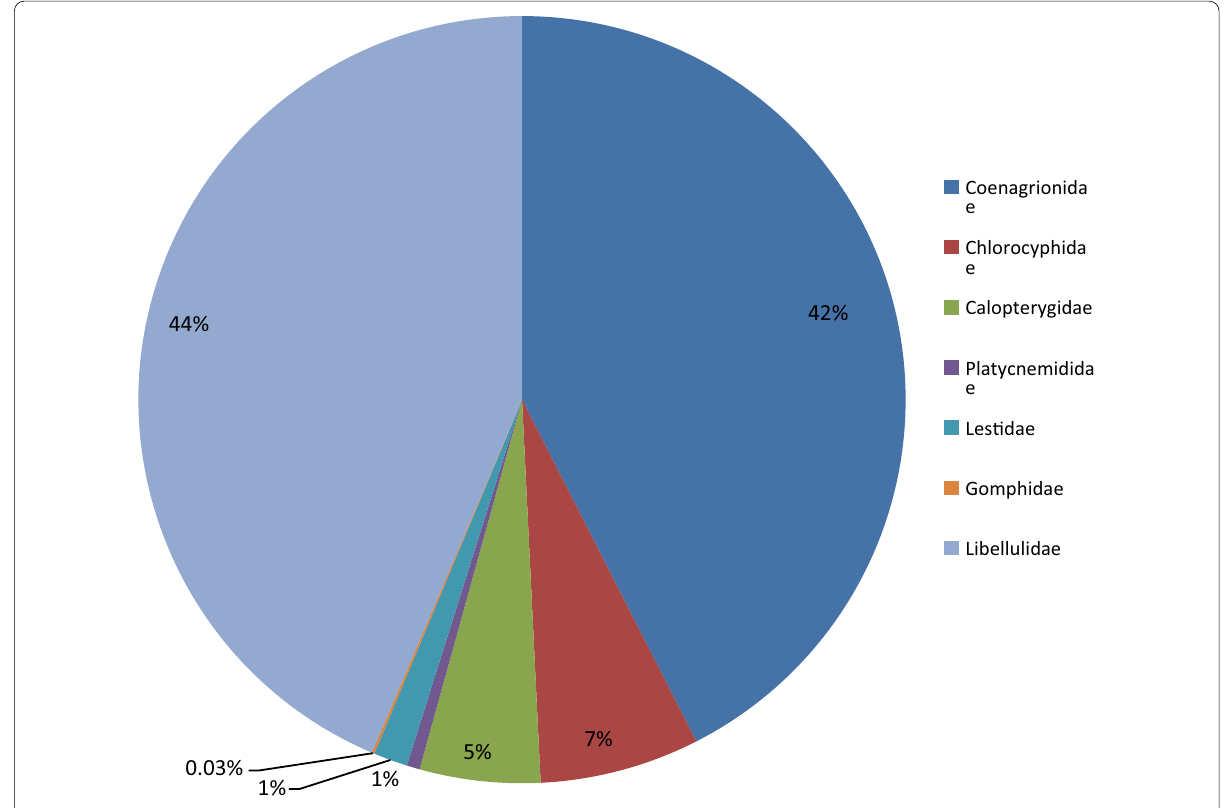
Fig. 2 Percentage composition of the seven Odonata families collected from three sites at Ipogun in